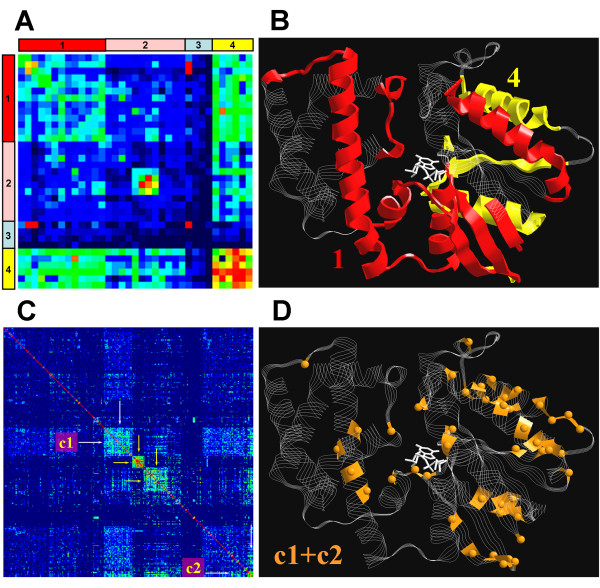
Color coded statistical coupling matrices and mapping of selected sites on the structure of Gαi. (A) Pair wise couplings of 35 secondary structure elements. Pixels indicate the values of statistical couplings (Nχ2) on a rainbow color scale (red: full coupling, dark blue: no coupling). The secondary structure elements are sorted according to the cluster analysis and cluster numbers are indicated on the sides of the matrix. (B) The elements in clusters 1 and 4 are shown on the structure of Gαi (colors of the the numbers match the colors of the clusters in panel A). These clusters include following elements: N-terminal helix, β1, β2, β3, α1, linker I, αA, αA-αB, αD-αE, αF, linker II (switch I), α3, α3-β5 (in #1), β2-β3 hairpin tip, β5-αG, α4, β6, β6-α5, α5 (in #4). (C) The original coupling matrix (361 × 361) is sorted according to the cluster analysis. Pixels indicate the values of statistical couplings (Nχ2) as in panel A. (D) Members of the two relevant clusters, indicated as c1 and c2 in panel C, are shown on the structure of Gαi as orange strips and spheres corresponding to their α-carbons. These sites correspond to (with SwissProt numbering of Gαi1): V34, V72, S75, I78, S80, F95, N149, T177, K180, V185, H188, F191, K192, L194, H195, S206, C214, A235, M240, H244, L248, S252, C254, N256, T260, K271, T284, Y296, E298, A300, A301, Q304, Q306, L310, N311, K312, R313, E318, I319, T321, T327, F334, D337, A338, T340. Coordinates of GTPγS-bound Gαi (PDB ID: 1GIA) is used to render 3D-structures. RasTop program v2.0.3 (Philippe Valadon, 2003) is used for 3D visualization.